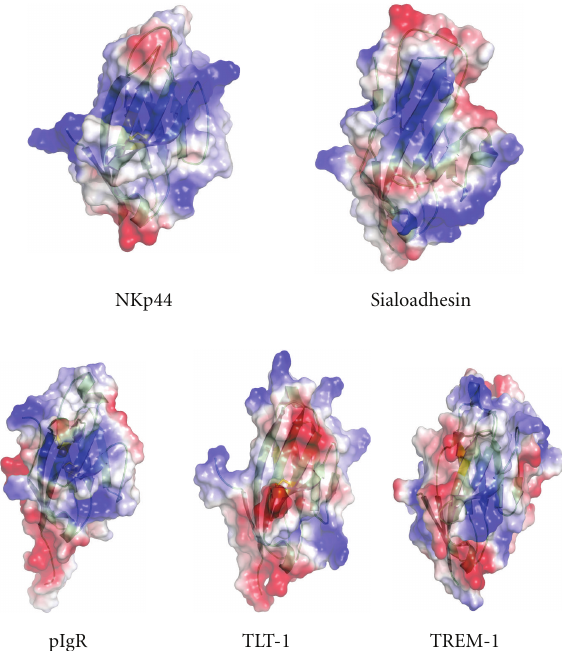
Figure 6: Charged surface representation of NKp44 and closely related homologues sialoadhesin, pIgR, TLT-1, and TREM-1. The orientation of each molecule is identical to that of NKp44 shown in Figure 4 and allows a view of the G, F, C, and C (cid:3) sheets of each molecule.